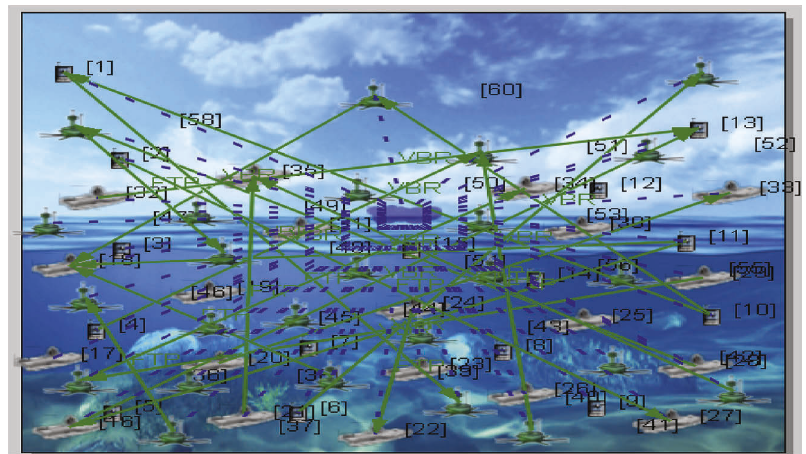
Figure 3: Proposed scenario of underwater wireless communication with various nodes in X-Y visualization.